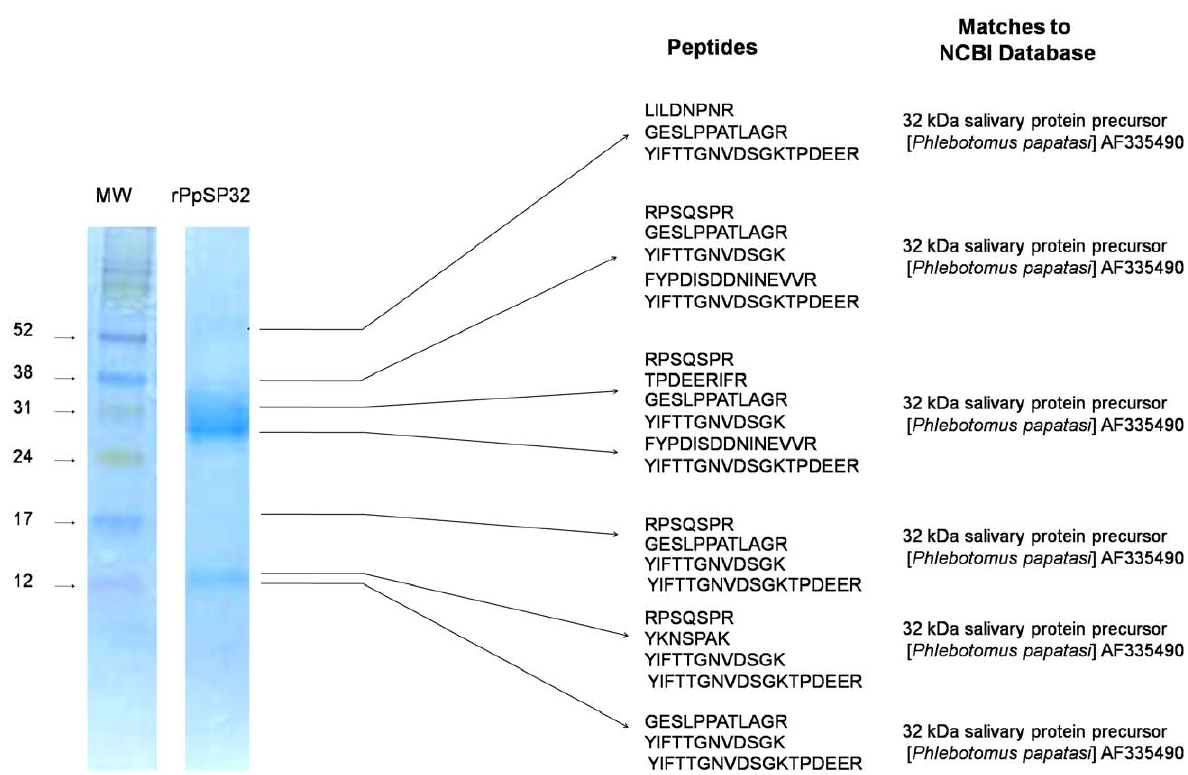
Figure 5. Identification of the different rPpSP32 bands by mass spectrometry. Recombinant PpSP32 (6 m g/well) was run on a 15% SDS- PAGE gel. Seven bands were cut from the gel after staining with Coomassie-blue and mass spectrometry was performed. The RPN800E molecular weight marker (Amersham) was used.